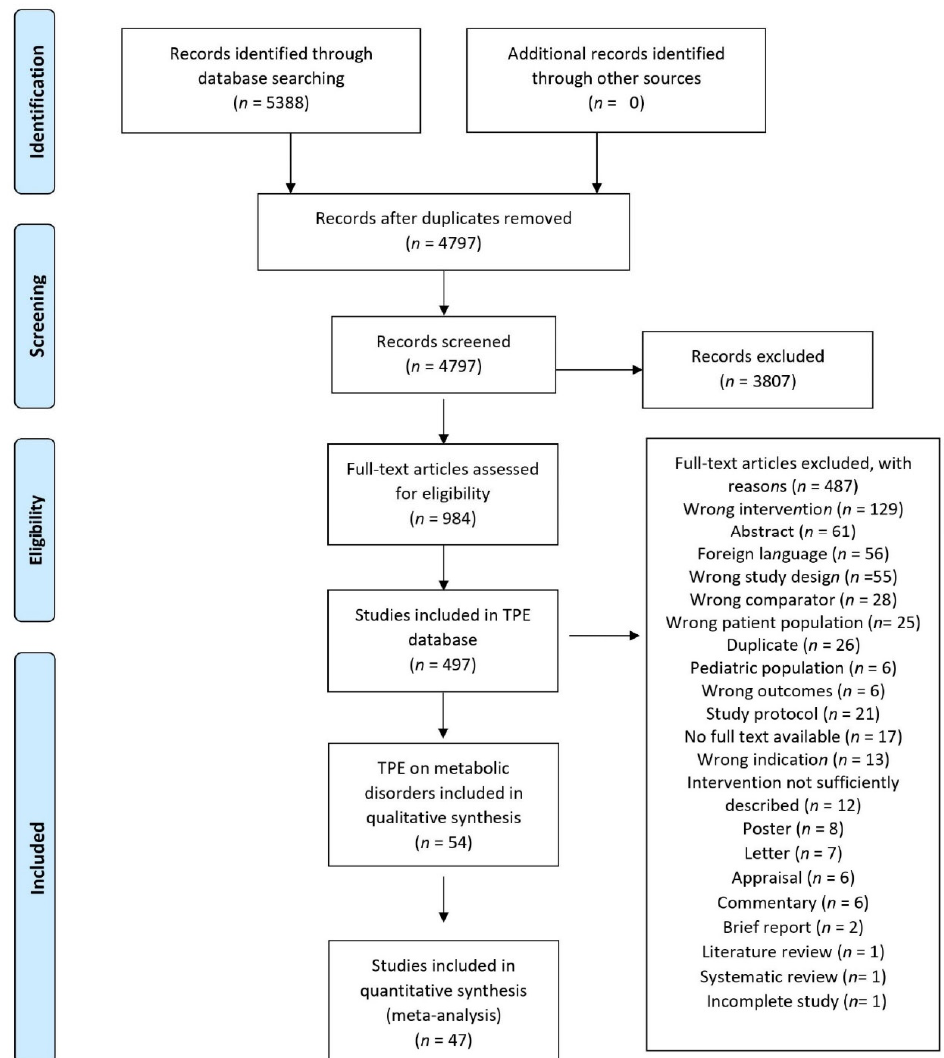
Figure 1. PRISMA flowchart for selection of eligible studies.